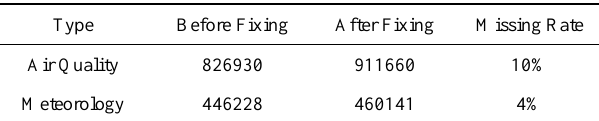
Table 1. Statistics of data before and after fixing missing values.